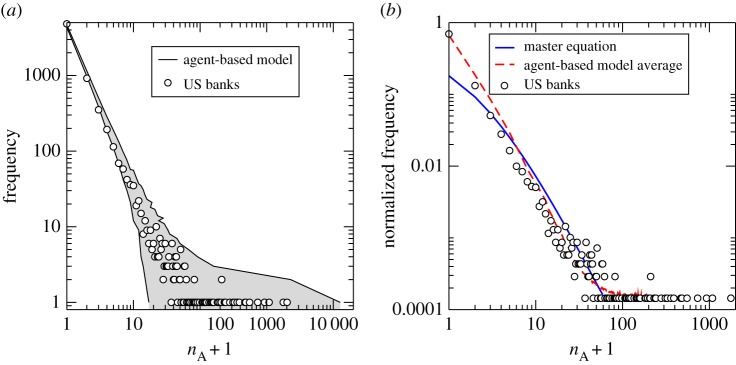
Comparison between the master equation, agent-based model and real data from the surviving population in the US banking sector. (a) The range of ancestry data obtained from the agent-based model over 1000 simulations (grey-shaded area), compared with that for the live population within the real US banking dataset (black circles). (b) A comparison with the master equation result. Both plots are shown as functions of the shifted ancestry variable nA+1.